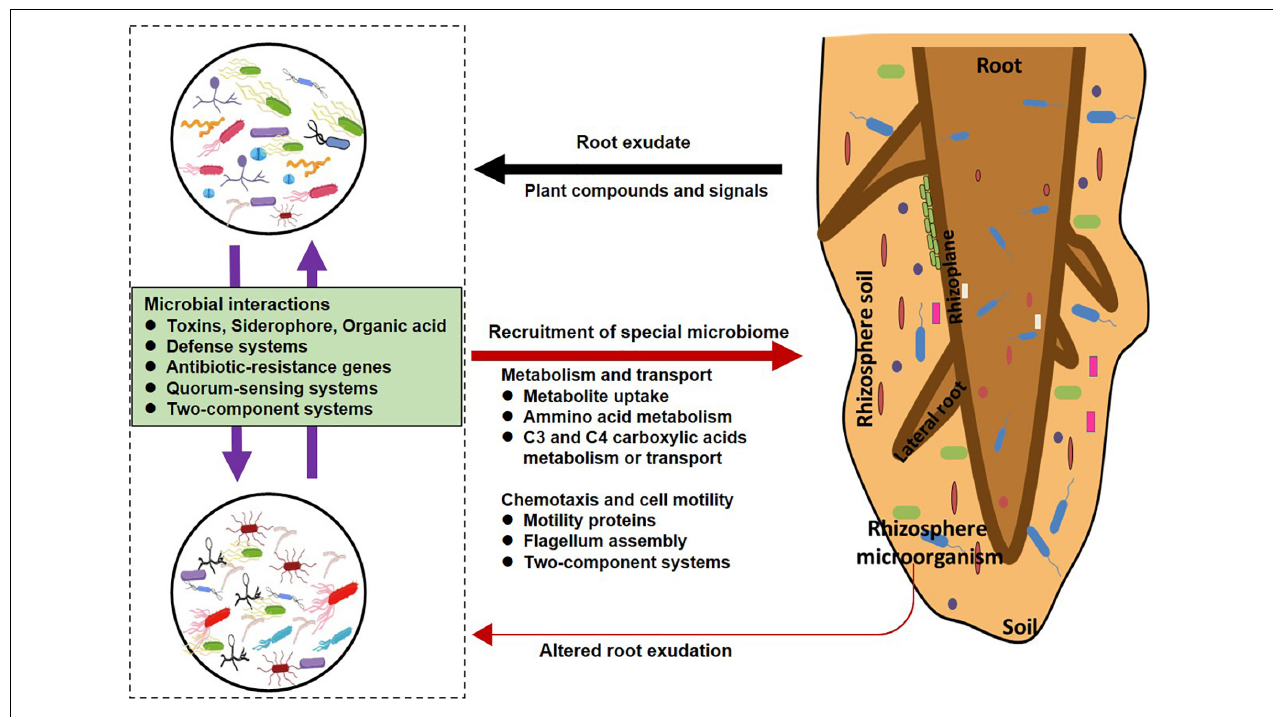
FIGURE 5 | Mechanisms of plant–microbe and microbe–microbe interactions in the rhizosphere. Plants can release root exudates into soil to manipulate soil microbial community assembly; they can recruit and are affected by special microorganisms. Microbial community is also affected by intense microorganism–microorganism interactions mediated via the strain-specific production and quorum-sensing or two-component